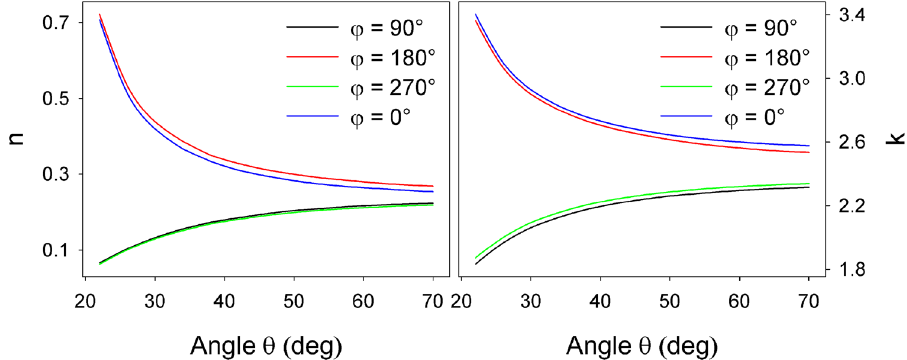
Figure 6. Real and imaginary part of pseudo-refractive index = +  n n ik of AgOADs and their variation with angles θ and ϕ as measured by standard ellipsometry. The values pertain to substrates after MB adsorption, λ = 532 nm. To compare, the refractive index of the bulk silver is ∼ .